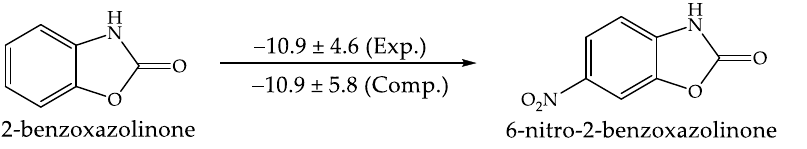
Scheme 2. Experimental and computational enthalpic increments from 2-benzoxazolinone to 6-nitro-2-benzoxazolinone (values in kJ · mol − 1 ).